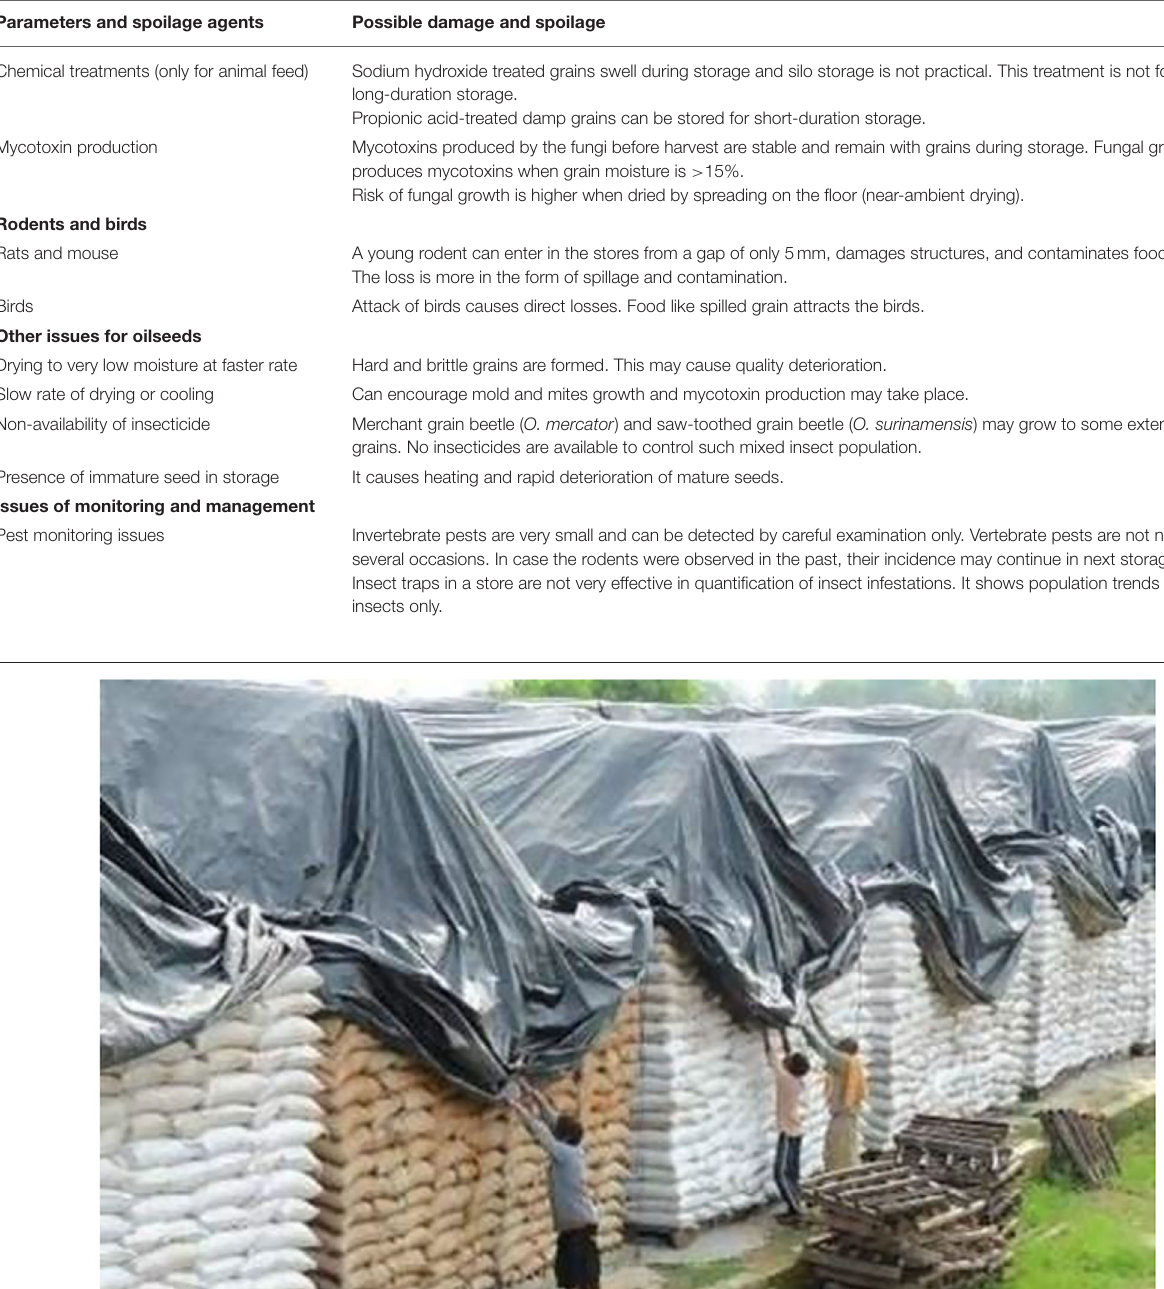
center to center are used. The upper member of dunnage is of 70 × 50 mm 2 cross-section, 1.5 m long, and five planks are placed at 237 mm distance from center to